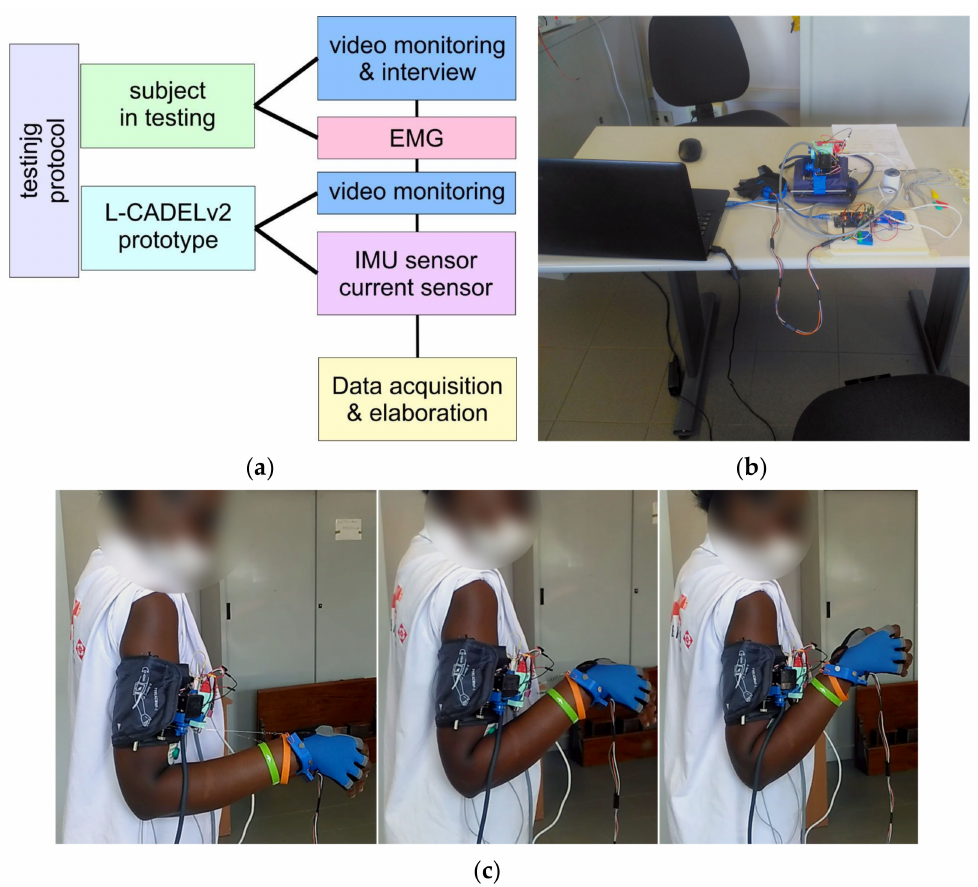
Figure 6. Setup for testing L-CADELv2 prototype: ( a ) A conceptual scheme; ( b ) Lab setup at LARM2 in Rome; ( c ) Snapshots from a lab test.